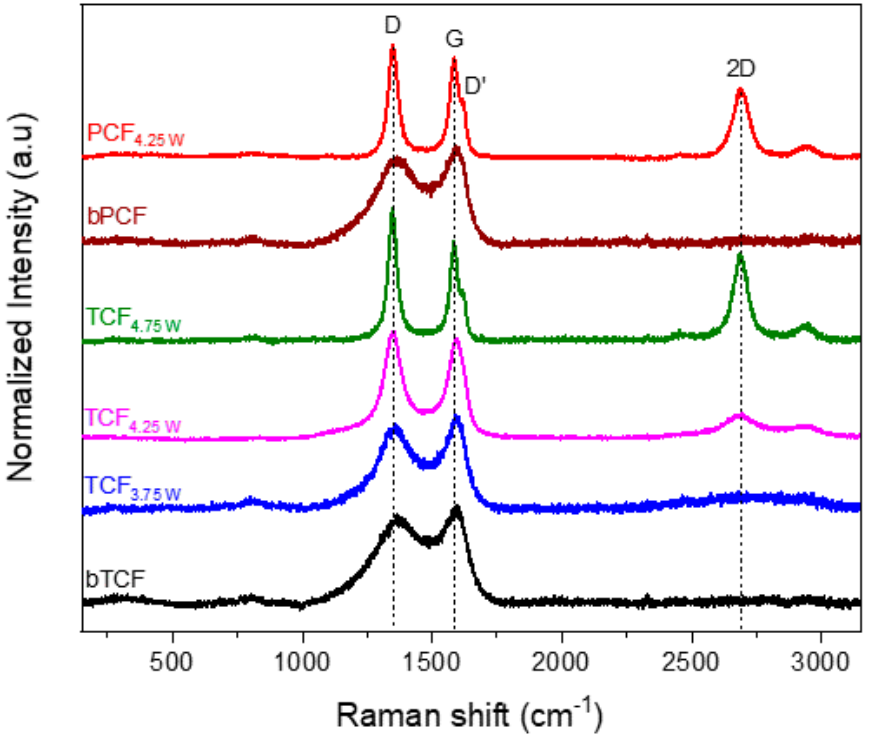
Figure 7. Raman analysis of the irradiated samples. TCF denotes Toray carbon fibers (T700SC), while PCF denotes the Pyrofil fibers (TR50S). bTCF and bPCF represent control bare non-exposed carbon fiber (CFs).